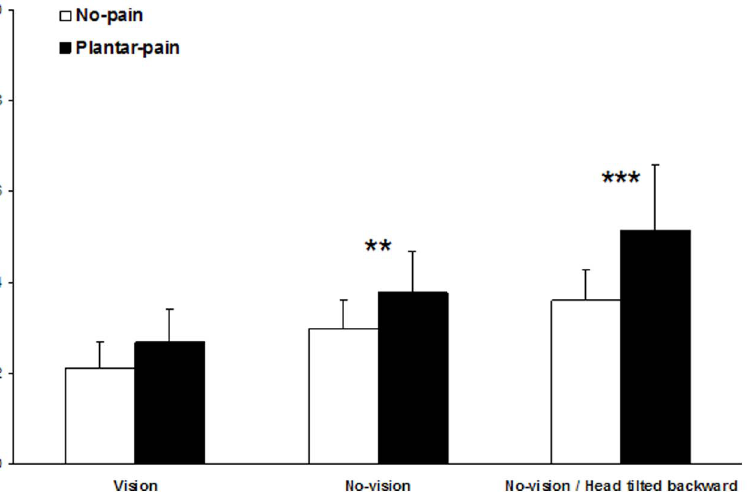
Figure 2. Mean and standard deviation of the standard deviation of the CoP displacements along the medio-lateral axis for the three sensory conditions and the two pain conditions. The No-pain condition is represented by white bars and the Plantar-pain condition by black bars . The significant P values for comparison between No pain and Pain conditions are reported (**: P , 0.01; ***: P , 0.001).